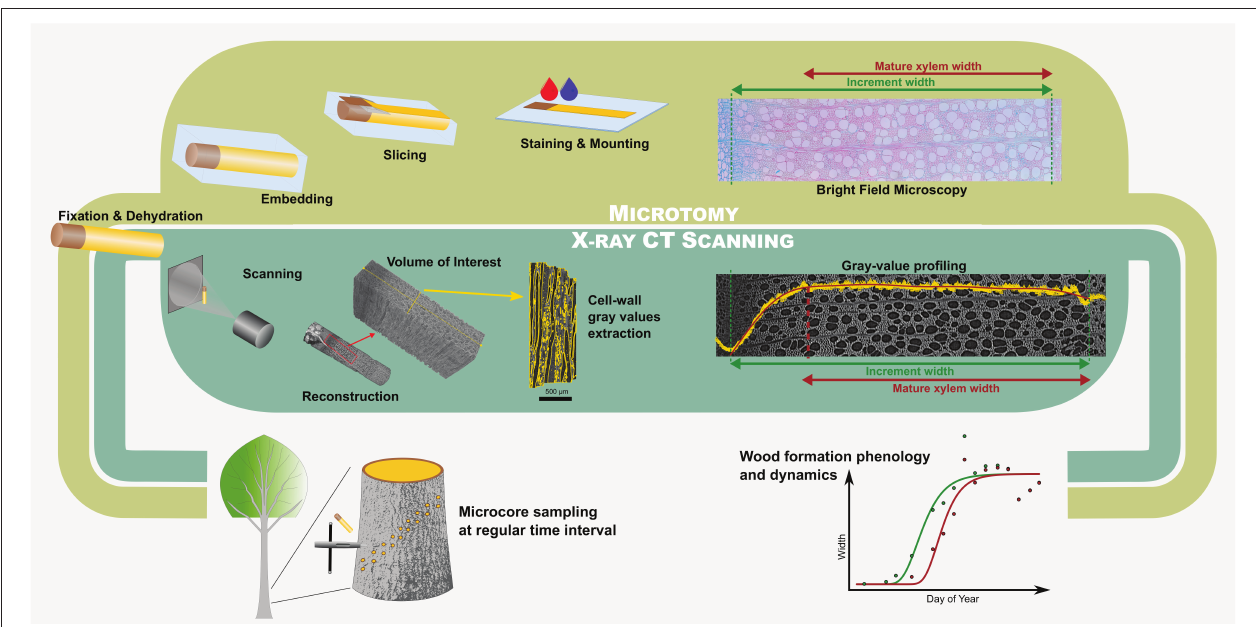
FIGURE 1 | Comparison between the microtomy and HXRCT workflow developed in the present study. The flowchart covers the different steps from field sampling to data analysis through sample preparation and data extraction.